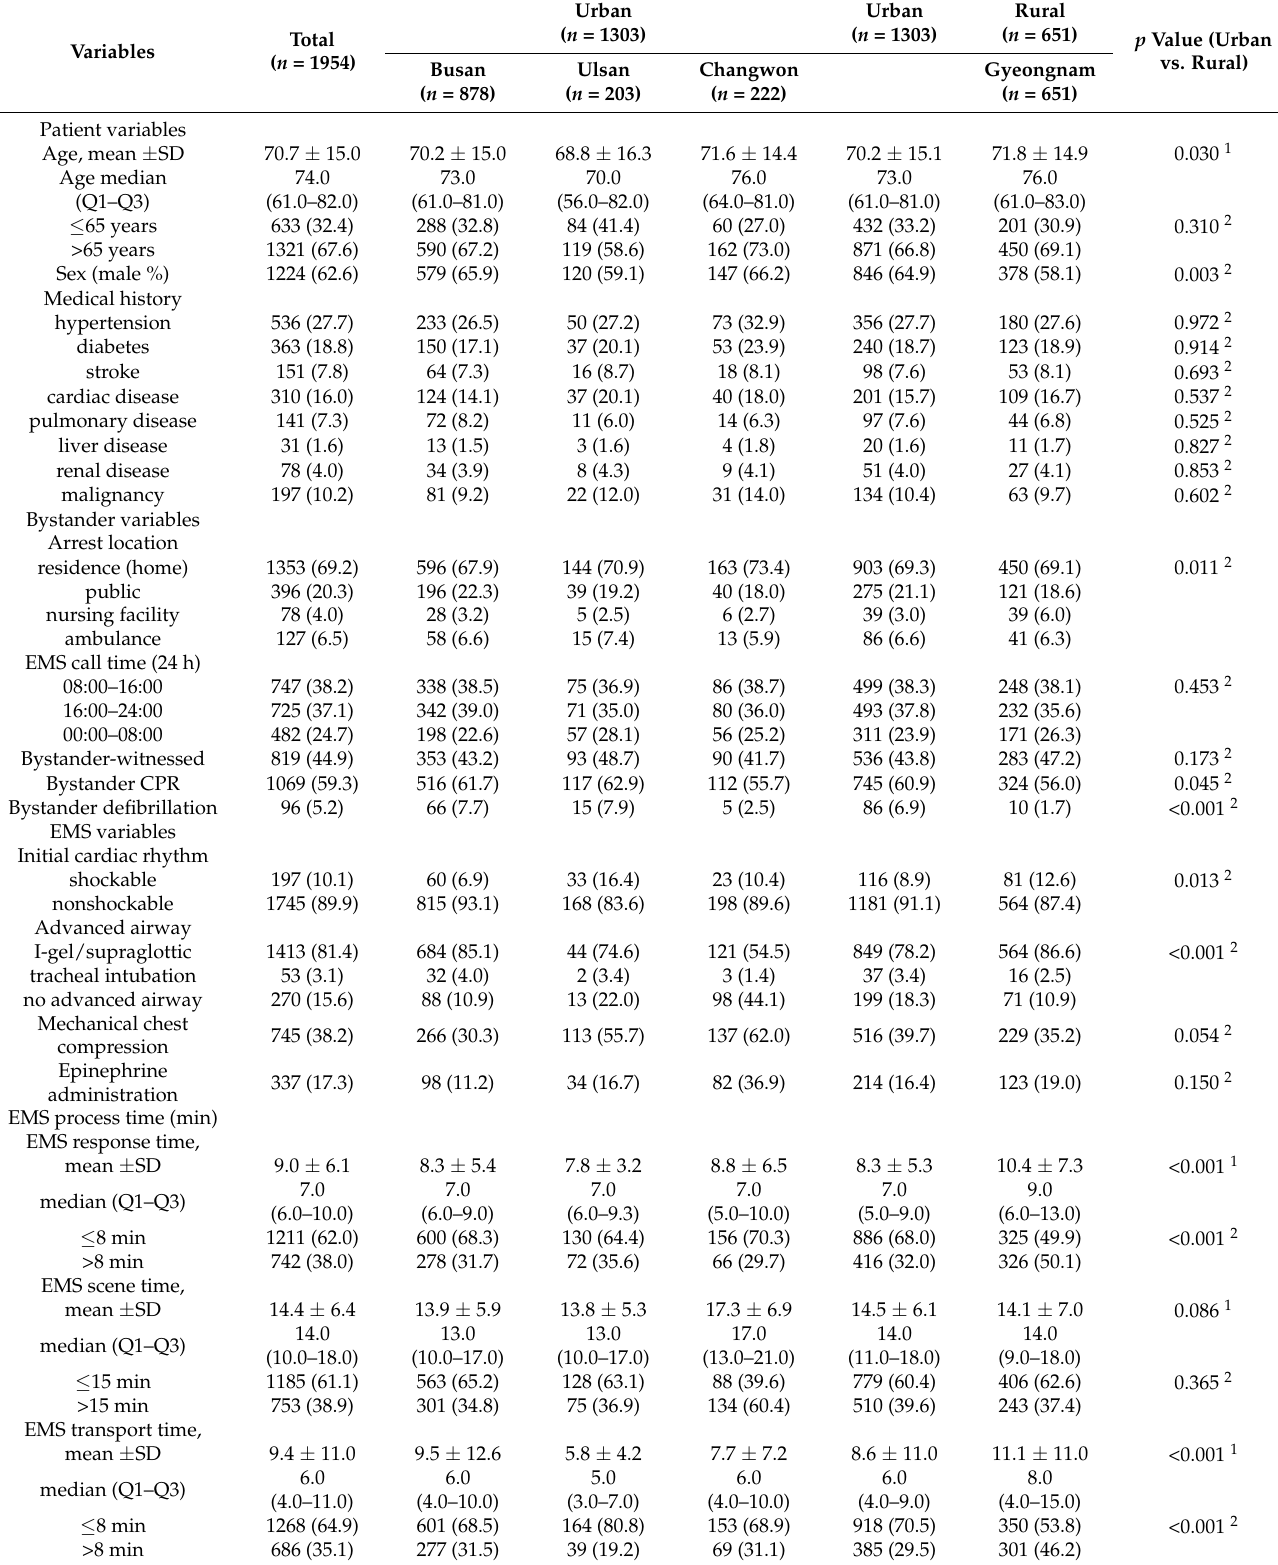
Table 1. Characteristics of the study